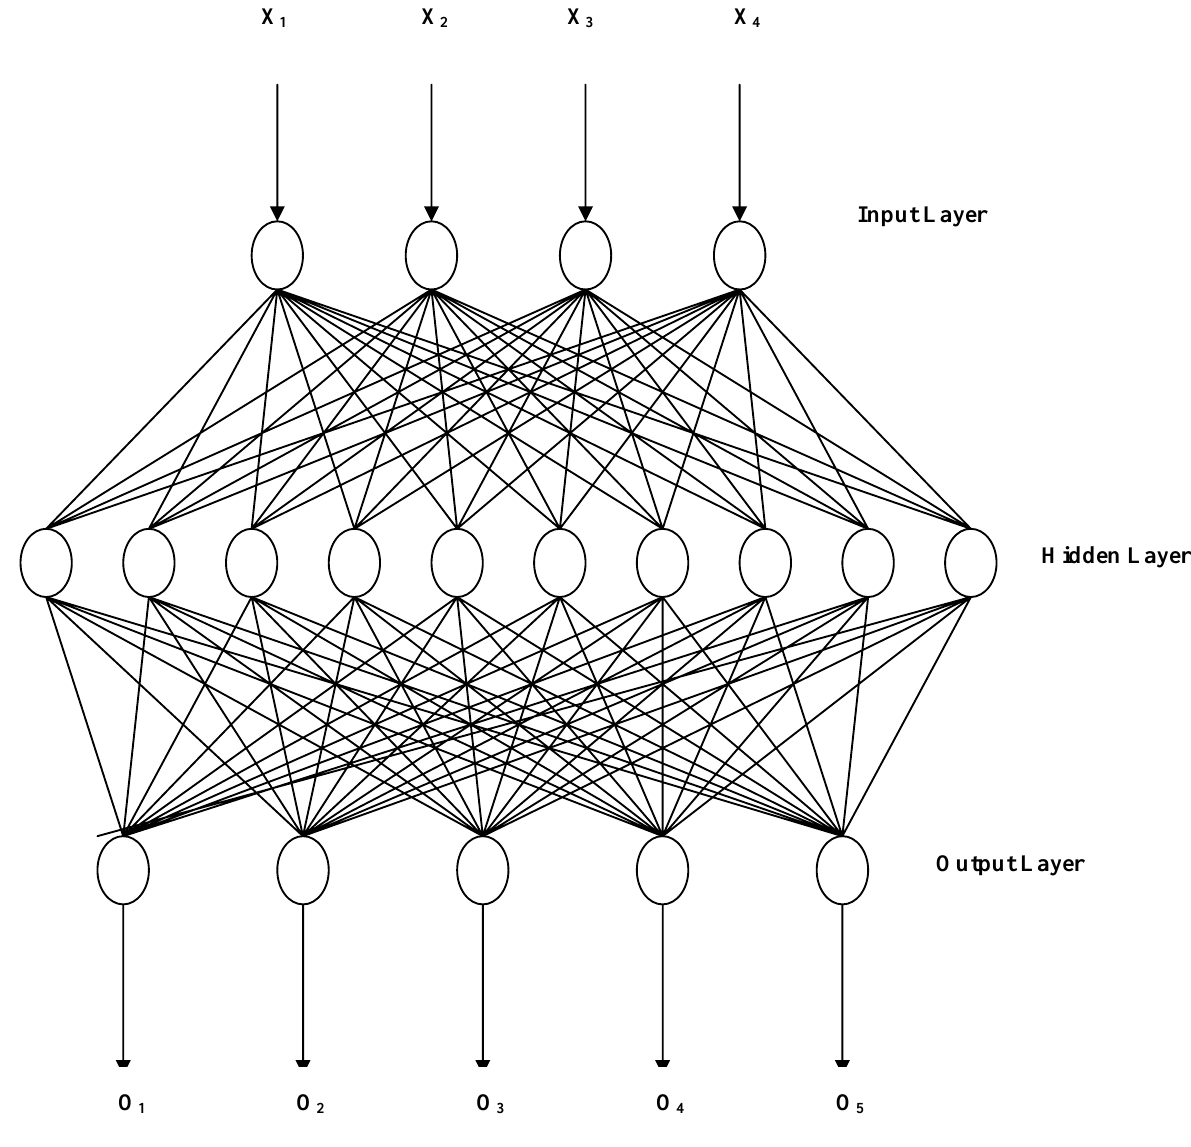
Figure 1. The structure of three-layer MLP neural network with 4 input nodes, 10 hidden nodes, and 5 output nodes. Each hidden layer is directly connected to each component of the input layer and also to each of the components in the output